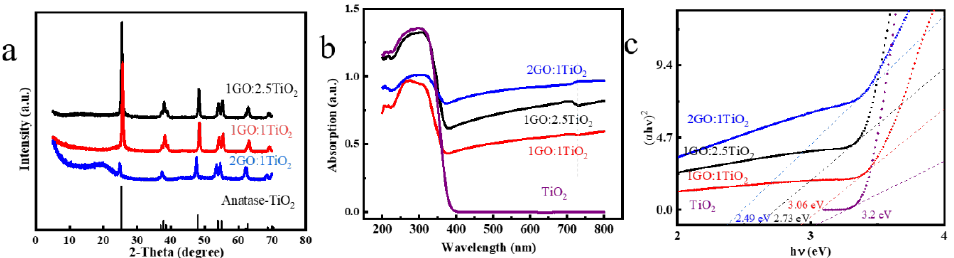
Figure 3. XRD patterns of the samples (TiO 2 , 1 GO:TiO 2 , 1 GO:2.5 TiO 2 , and 2 GO:1 TiO 2 ) ( a ); DRS spectra of the catalysts ( b ); and Tauc plots of the samples to determine the band gaps ( c ).